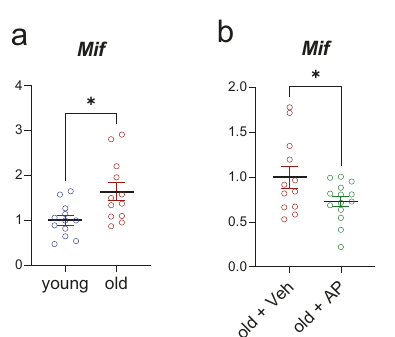
Fig.6|TheinsilicopredictedimportanceoftheMifpathwayisre fl ectedinthe aged INK-ATTAC mouse model. a We compared young ( n =12) and old vehicle- treated mice ( n =13), and old mice treated with AP ( n =16). a Upregulation of Mif was con fi rmed by RT-qPCR ( n =24 young (12 Veh, 12 old (all female), p =0.0102)); b Theclearance of senescentcellsintheagedcohortbyAPtreatmentreducedthis Mif expression ( n =26 old [12 Veh, 14 AP, all female], p =0.0459). * p <0.05. Two- sided unpaired t -tests. Source data are provided as a Source Data fi